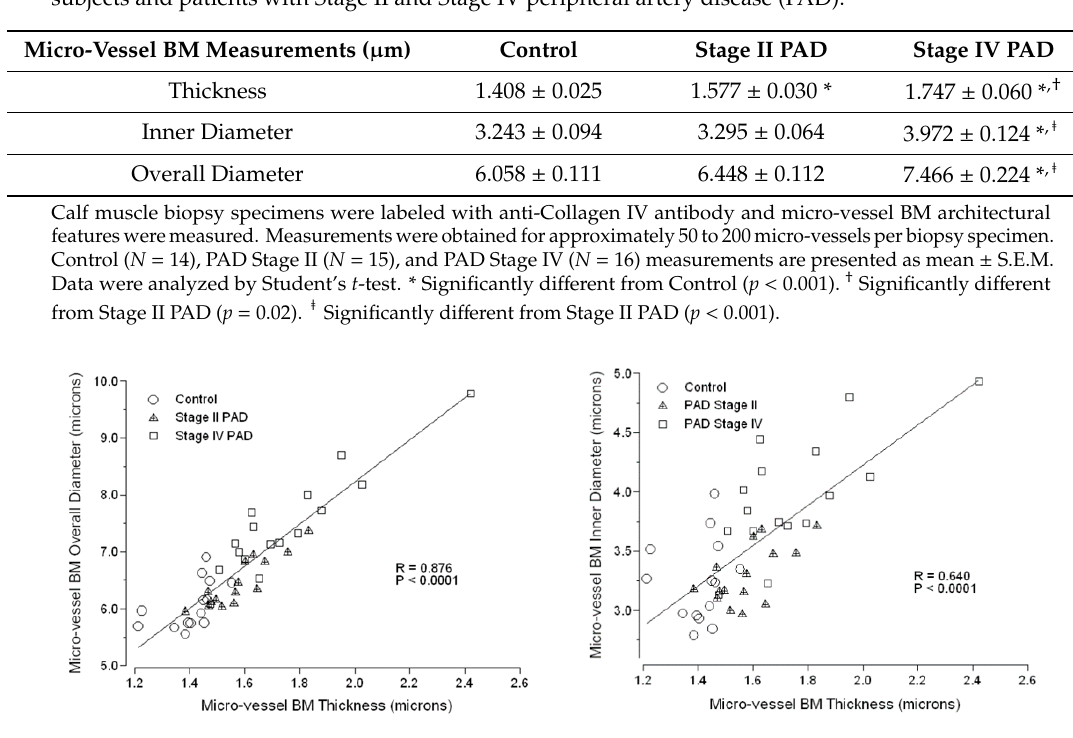
Table 2. Measurements of the basement membrane of micro-vessels in the calf muscle of control subjects and patients with Stage II and Stage IV peripheral artery disease (PAD). Table 1. Patient demographics.